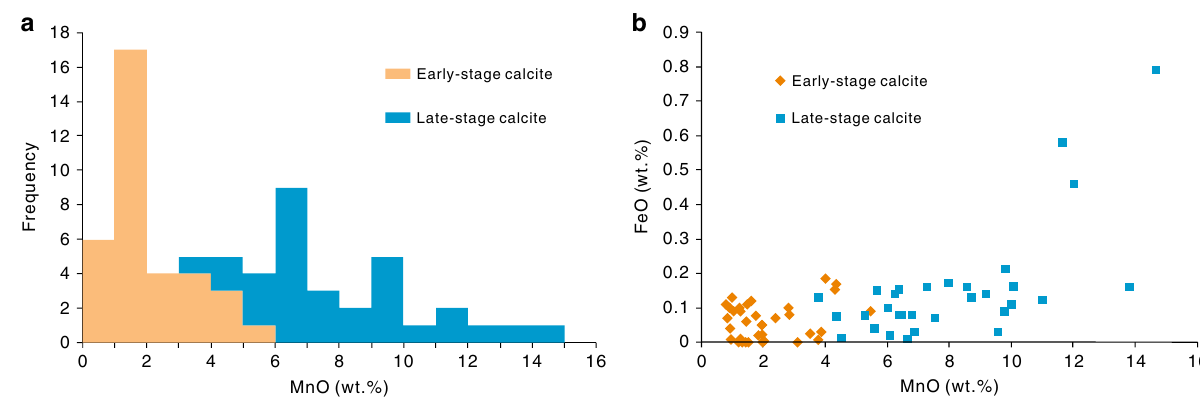
Fig. 3 Manganese and iron contents in authigenic calcites. a Histogram of MnO content in early-stage and late-stage calcite cements from T 1 b sandy conglomerates. b Crossplot of MnO and FeO content in early-stage and late-stage calcite cements from T 1 b sandy conglomerates. The error bar (±SEM) is smaller than the symbol size. Source data are provided as Supplementary Data 1